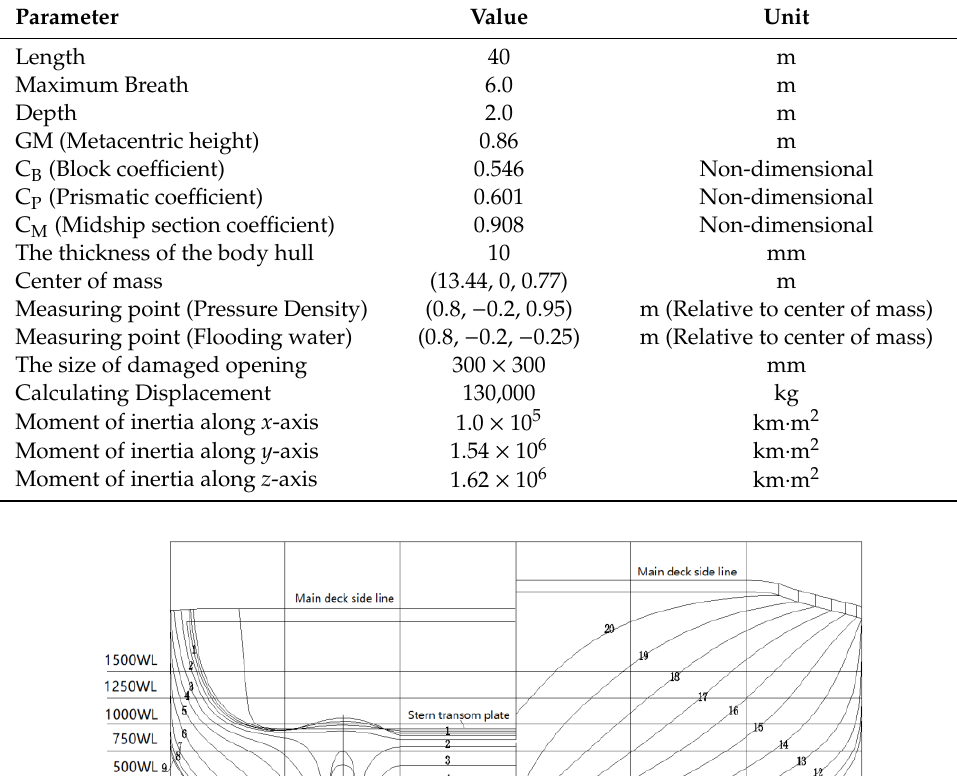
Table 2. Main particulars of the damaged ship.